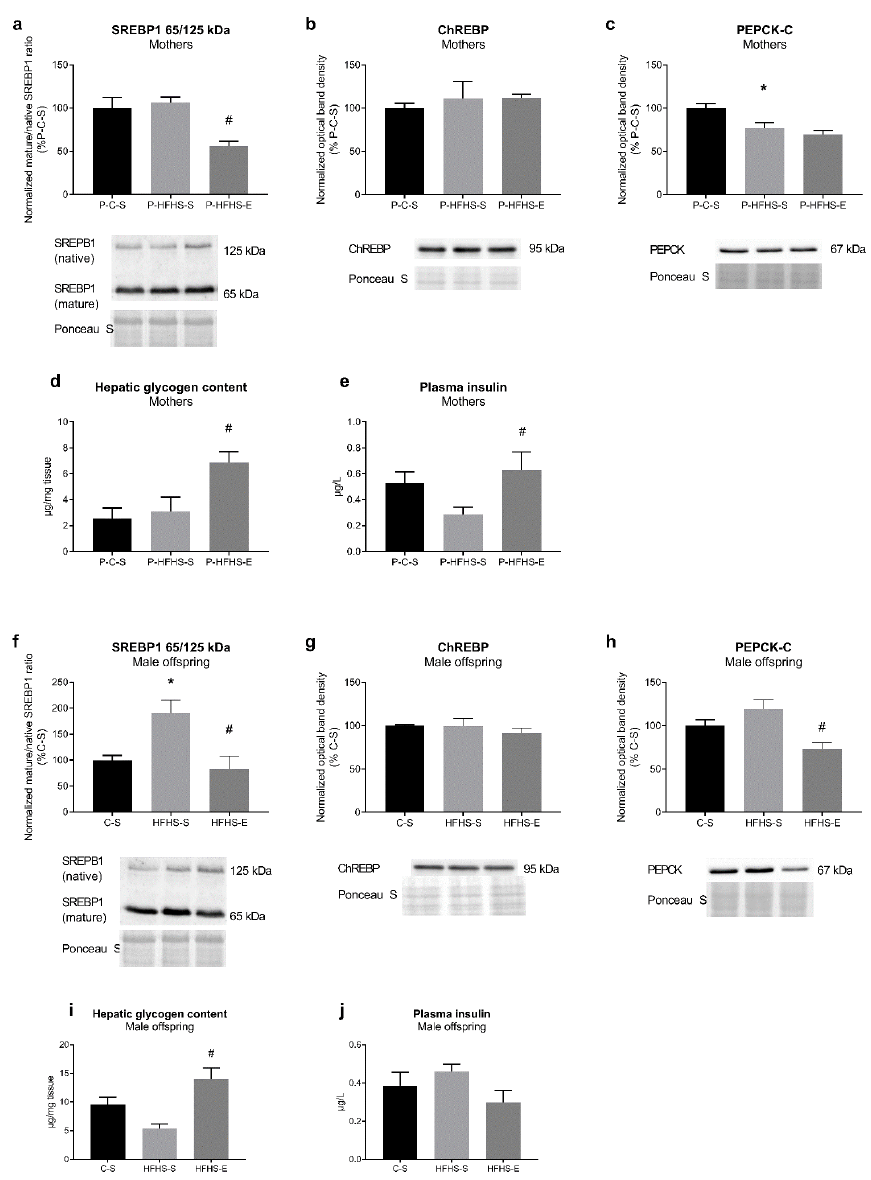
Figure 1. Effects of maternal HFHS and GE on regulators of liver glucose and lipid metabolism in mothers: ( a ) ratio of mature (65 kDa) and native (125 kDa) SREBP-1 form, ( b ) relative content of ChREBP, ( c ) relative content of PEPCK, ( d ) hepatic glycogen content, ( e ) plasma insulin levels; and in offspring: ( f ) ratio of mature and native SREBP-1 form, ( g ) relative content of ChREBP, ( h ) relative content of PEPCK, ( i ) hepatic glycogen content, ( j ) plasma insulin levels. GE—gestational exercise; C—mothers fed with control diet; HFHS—mothers fed with high-fat high-sucrose diet; S—sedentary mothers; E—exercised mothers. * vs. P-C-S ( p < 0.05) or vs. C-S ( p < 0.05) in mothers or offspring, respectively. # vs. P-HFHS-S ( p < 0.05) or vs. HFHS-S ( p < 0.05) in mothers or offspring,